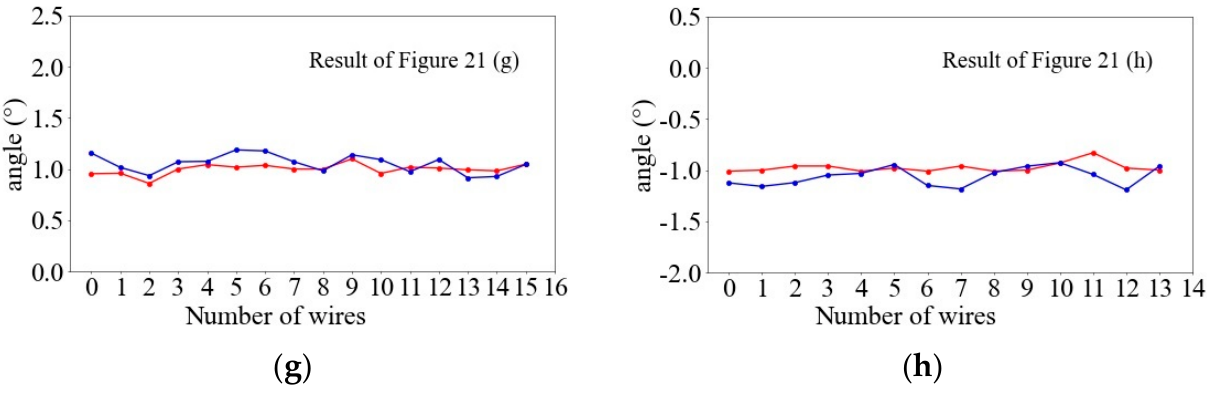
Figure 22. Comparison of the algorithm-detected angle and the manual-detected angle for each wire: ( a – d ) are the detection results of 2.4 mm wire; ( e – h ) are the detection results of 2.6 mm wire. The horizontal coordinate represents the wire number from the left in the ROI image, the vertical coordinate represents the angle-taking interval, the red dash is the algorithm-detected angle, and the blue dash is the angle ruler detection result.